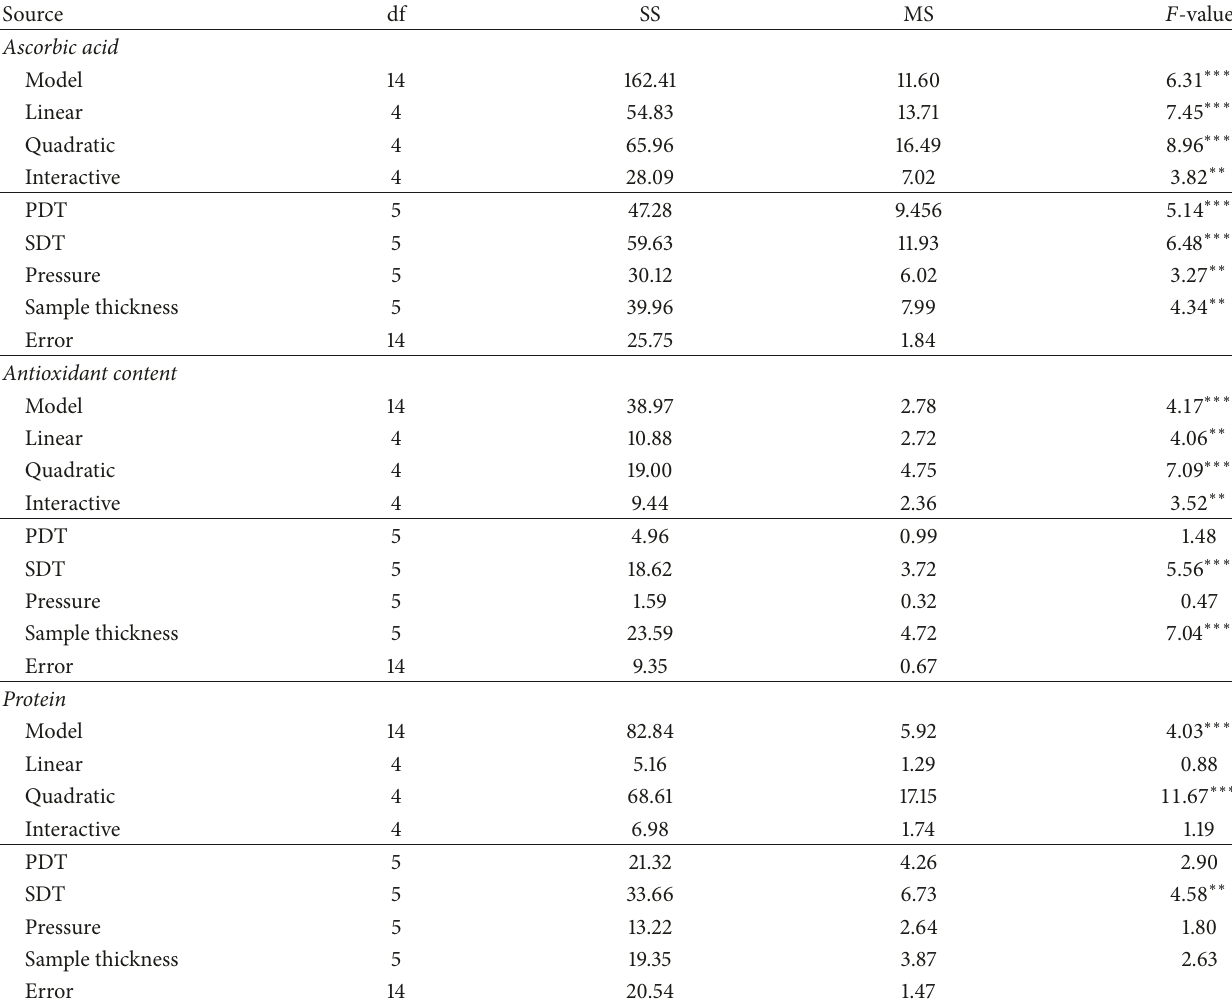
Table 3: Model characteristics and effect of individual parameters on the freeze-drying of mushrooms. Source